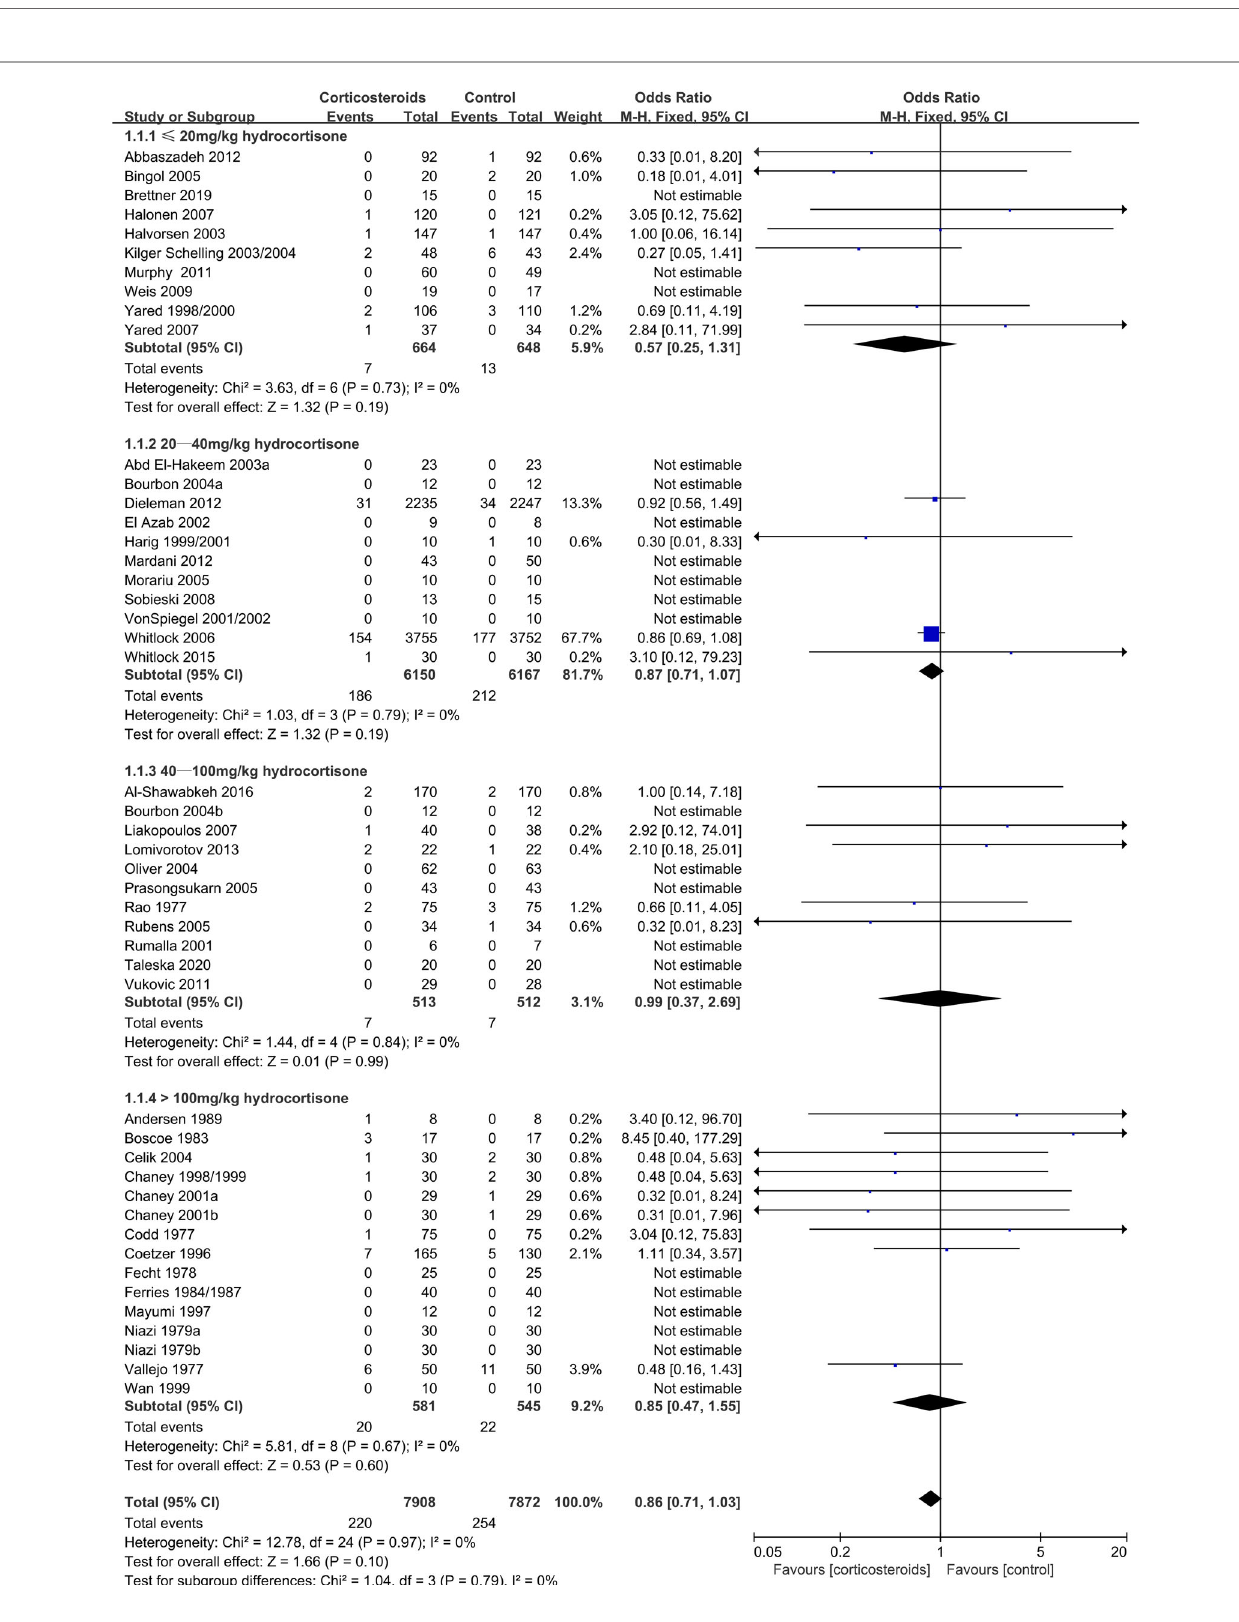
FIGURE 3 | Impact of corticosteroids on mortality